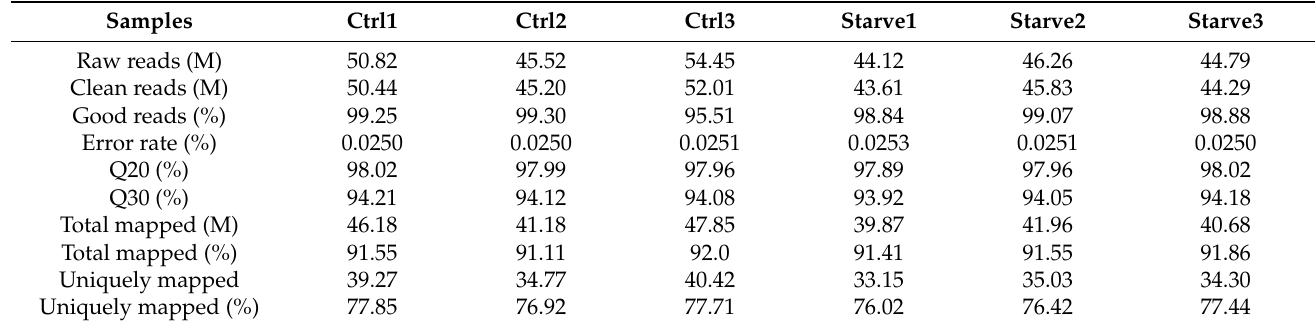
Table 1. Statistical analysis of sequencing